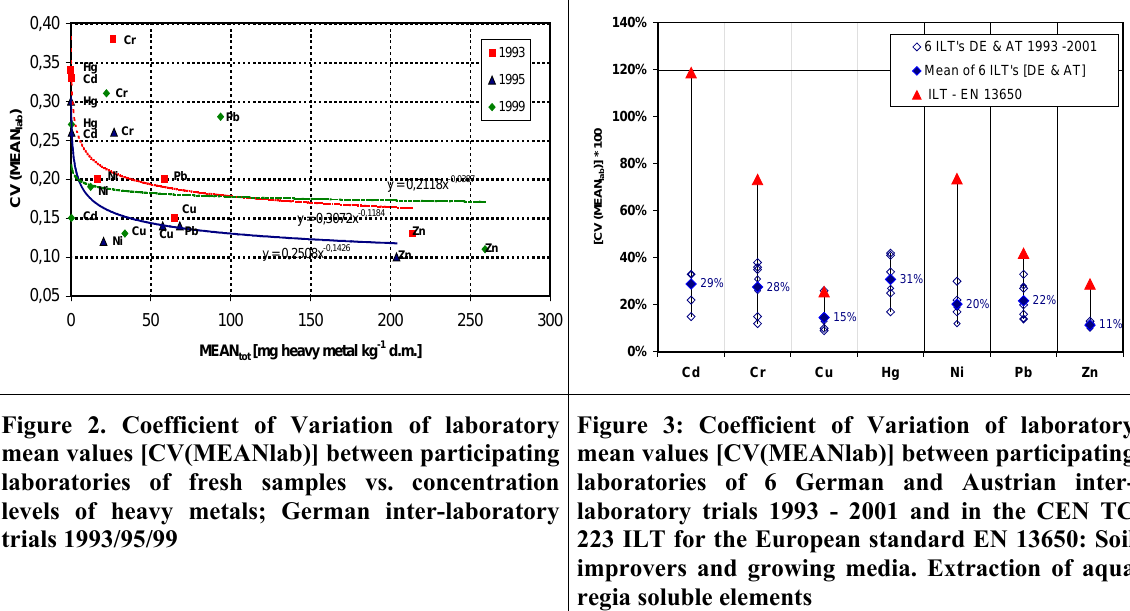
Figure 2. Coefficient of Variation of laboratory mean values [CV(MEANlab)] between participating laboratories of fresh samples vs. concentration